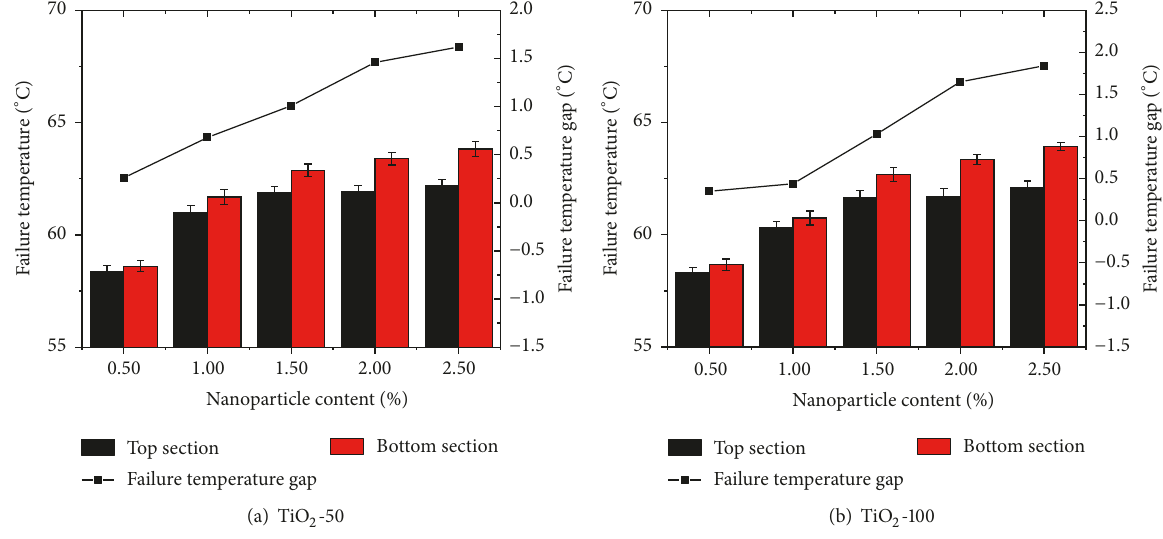
Figure 5: The effects of nanoparticle content on the failure